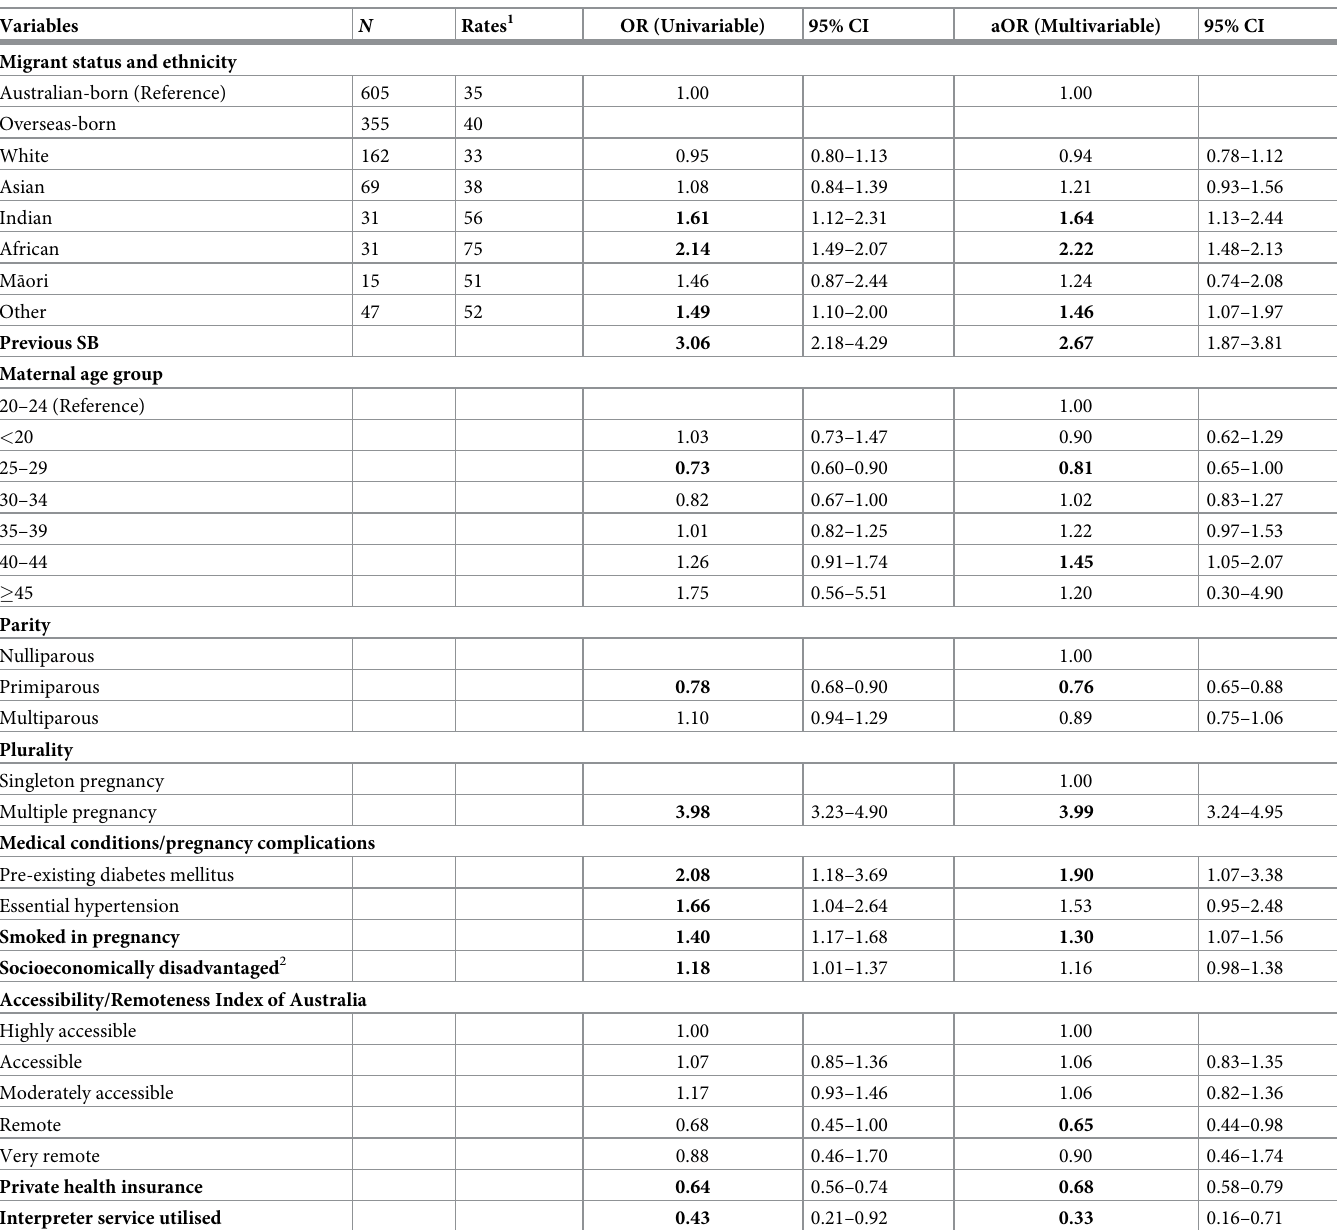
Table 3. Logistic regression model and the factors associated with AnteSB